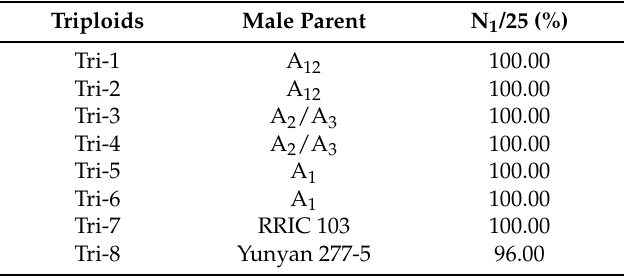
Table 5. Male parent’s identification of all